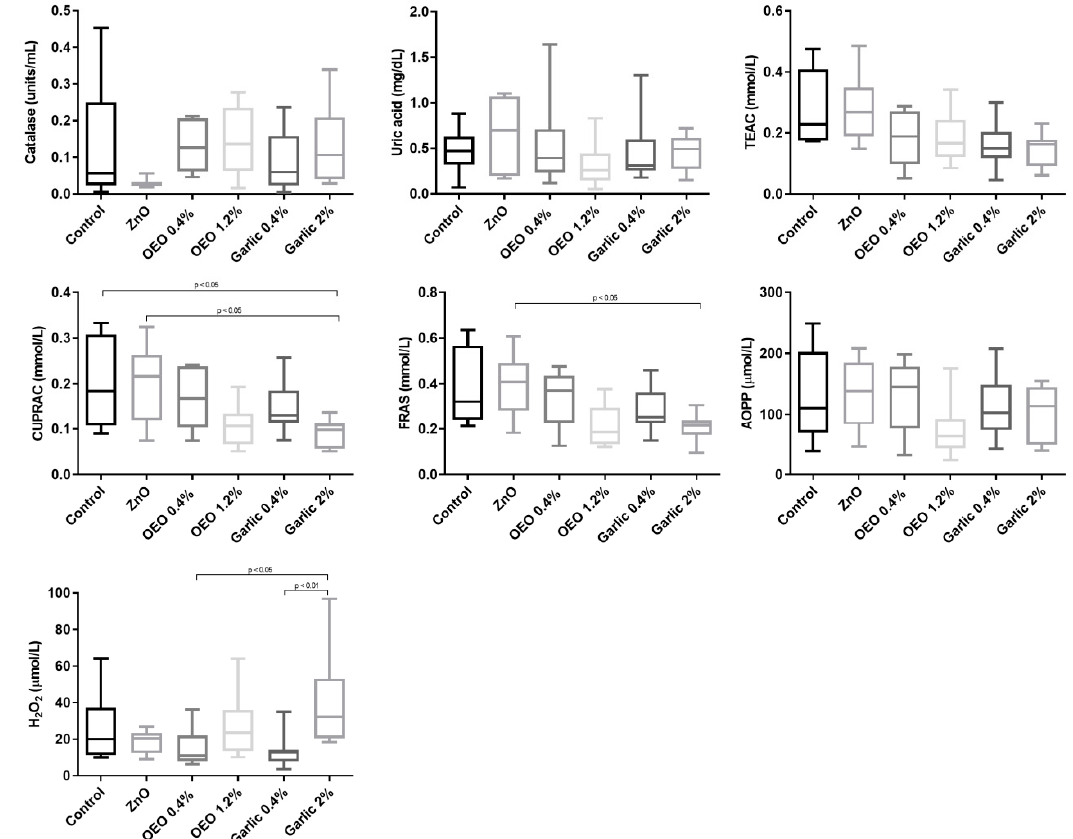
Figure 2. Results for salivary catalase, uric acid, Trolox equivalent antioxidant capacity (TEAC), cupric reducing antioxidant capacity (CUPRAC), ferric reducing ability of saliva (FRAS), advanced oxidation protein products (AOPP), and hydrogen peroxide (H 2 O 2 ) in piglets supplemented with ZnO, micro capsuled OEO at a concentration of 0.4% in the basal diet, micro capsuled OEO at a concentration of 1.2% in the basal diet, garlic powder at a concentration of 0.4% in the basal diet, and garlic powder at a concentration of 2% in the basal diet. The plots show median (line within box), 25th and 75th percentiles (box), and minimum and maximum values (whiskers).